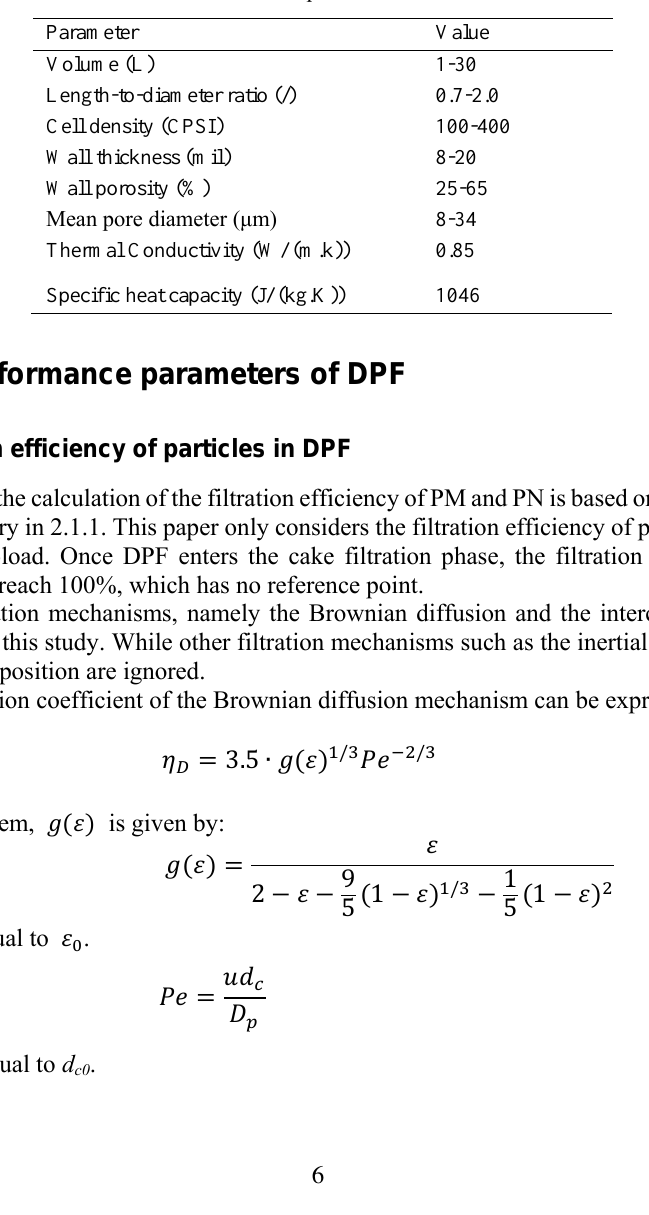
Table 1. Technical parameters of the